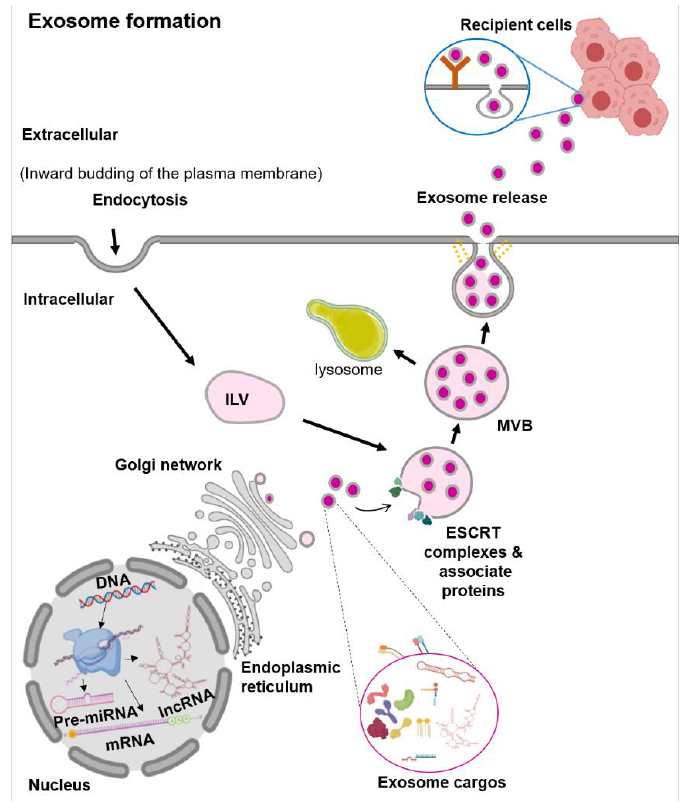
Figure 1. Schematic representation of the exosome biogenesis. Abbreviation: endosomal sorting complex required for transport (ESCRT), intraluminal vesicles (ILV), multivesicular bodies (MVBs).